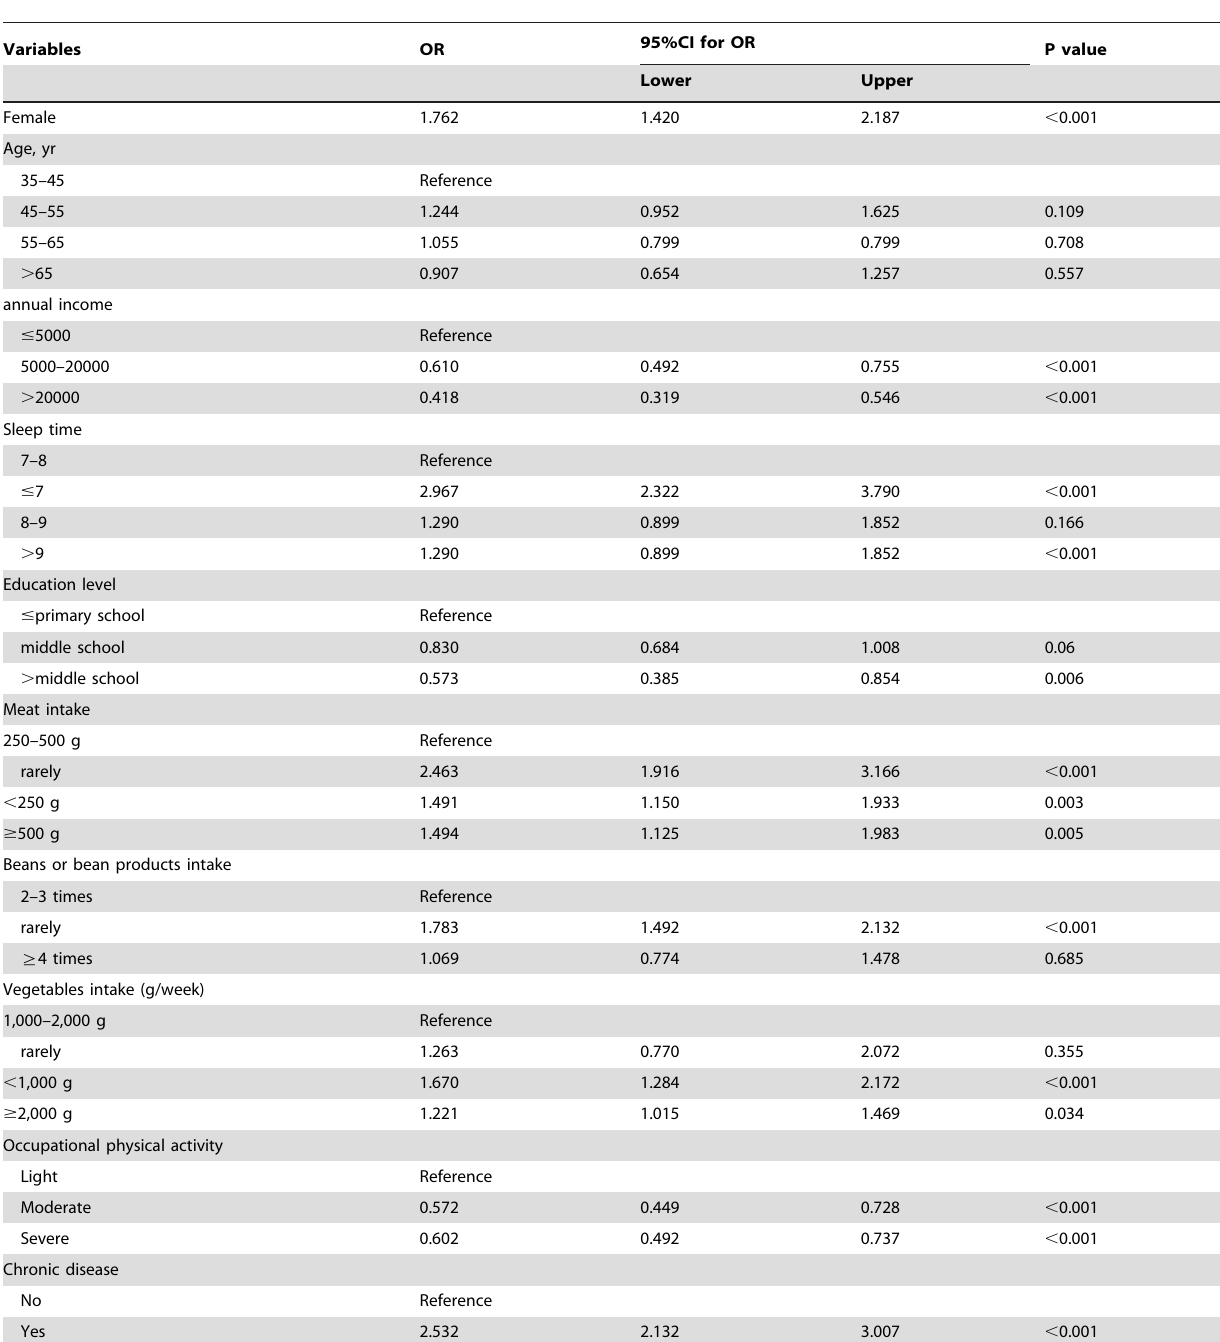
Table 3. Sex-dependent Risk Factors Associated With Different PHQ-9 Score Classes From the Multivariate Logistic